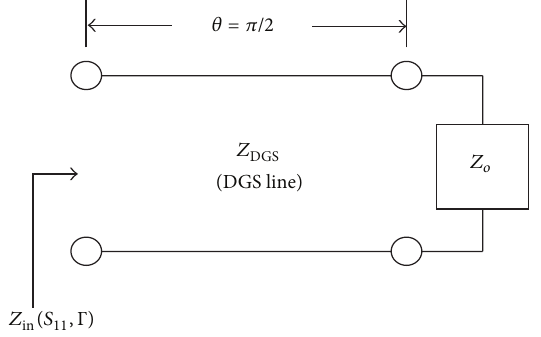
Figure 5: Equivalent circuit model to determine the characteristic impedance of the DGS